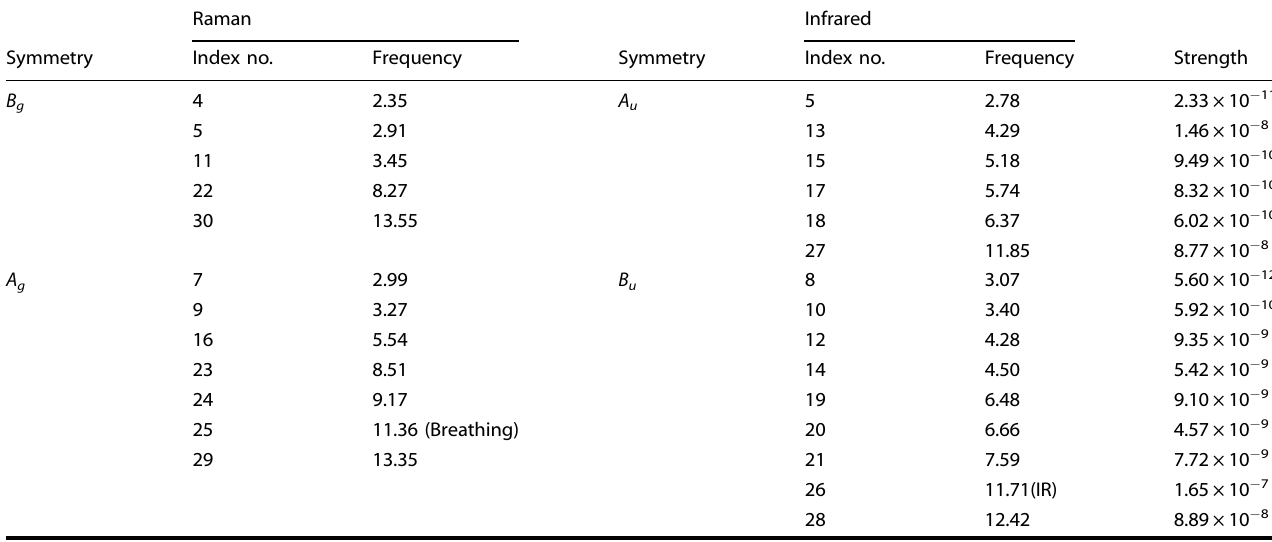
For all the IR modes, the phonon-phonon coupling strengths to the A g (25) breathing mode are also provided (in eV).